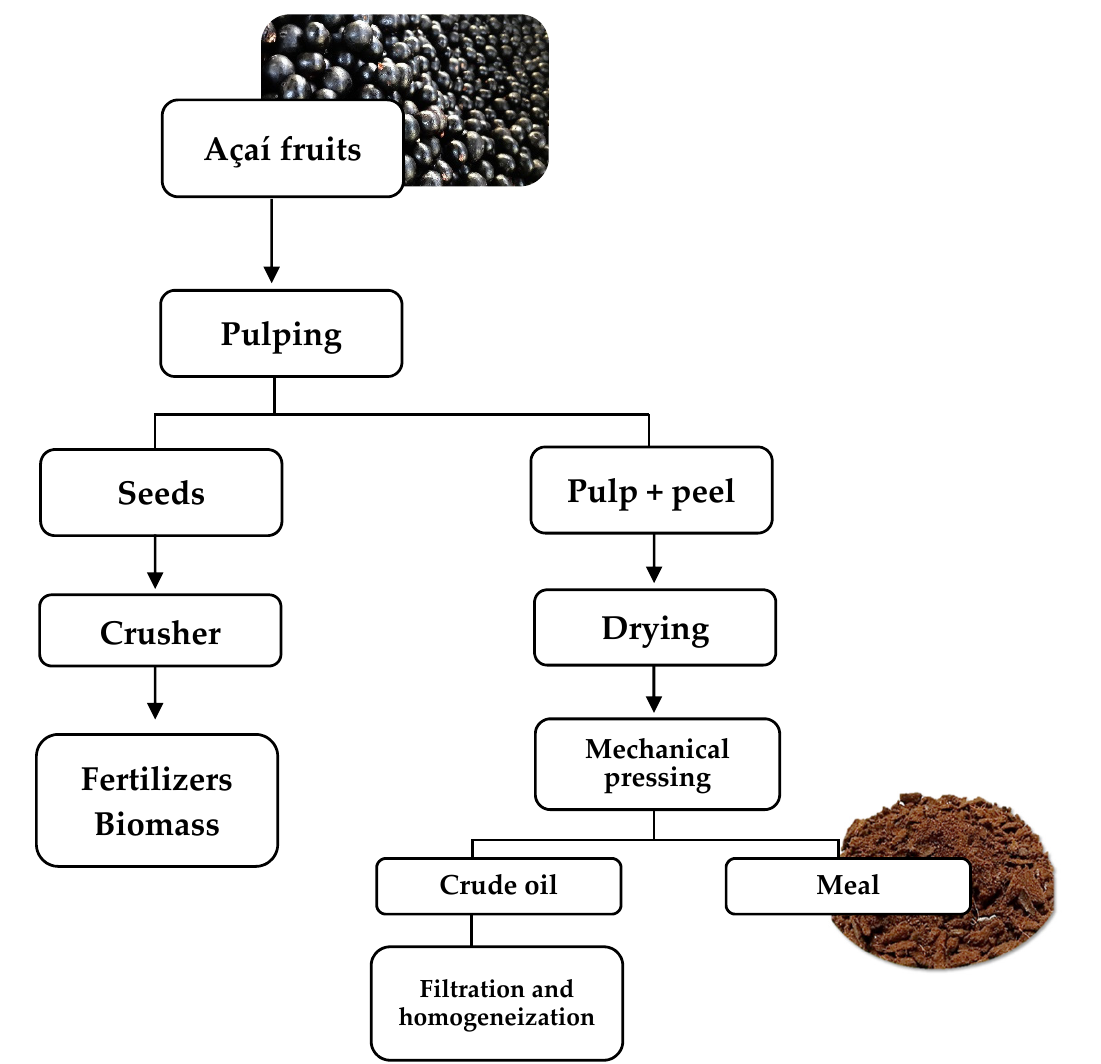
Figure 1. Flow diagram for the açaí processing. After the cryogenic milling of the sample, 4 g were mixed with 20 mL of hexane (1:5, w/v ) for defatting, followed by stirring, and centrifugation (5000 × g , 10 min). This process was performed twice. The precipitate was recovered, and the solvent was evaporated.